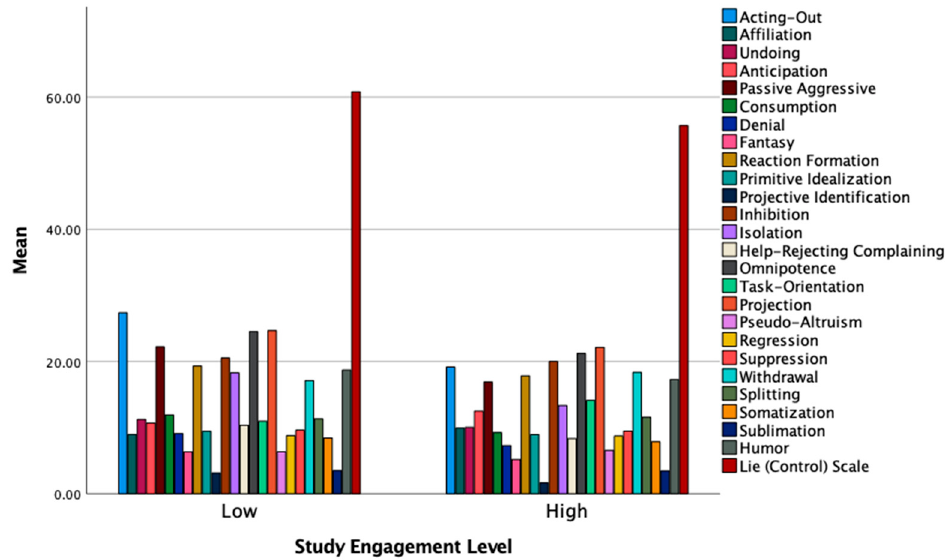
Figure 2. Mean levels of the defense mechanisms and the Lie scale by low and high Study Engage- ment.